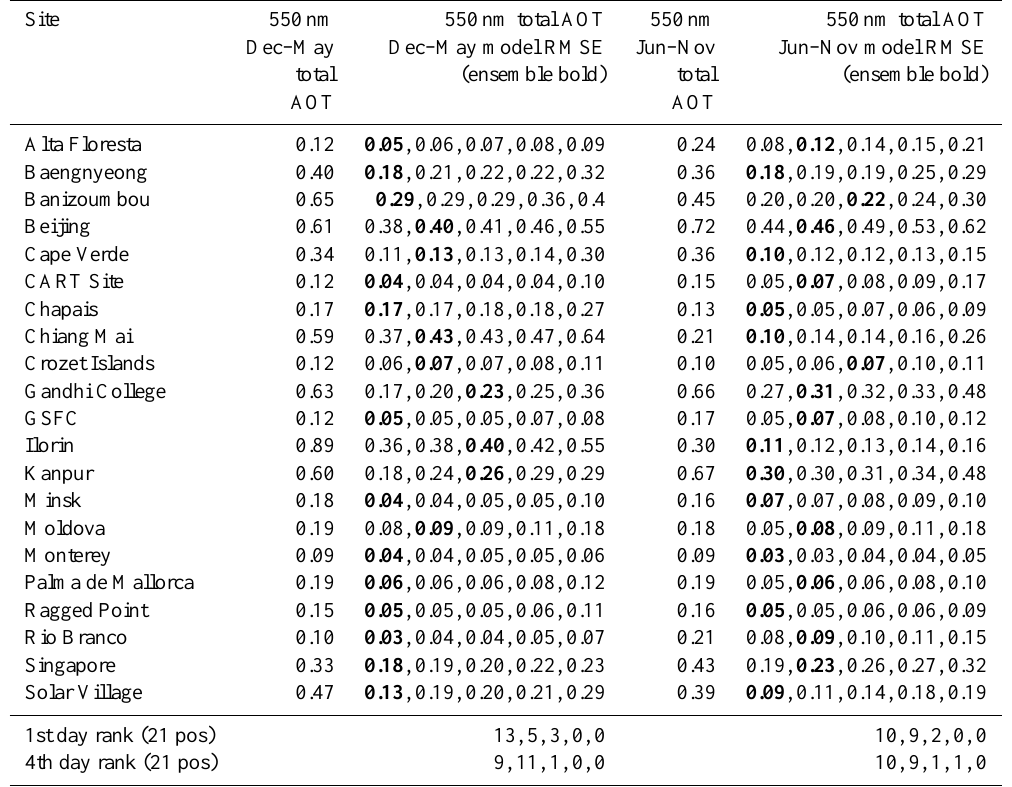
Table 3. List of + 1-day forecast 550nm total AOT RMSE from study core AERONET sites. These are followed by list of model biases for the four core ICAP members listed sequentially low to high for each site. The ICAP-MME ensemble mean bias is bold.